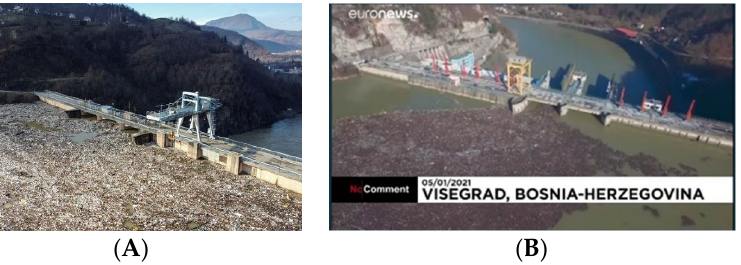
Figure 3. ( A ). Accumulation of litter debris, primarily plastic, near Potpecko Lake hydroelectric dam, Serbia, 5 January 2021. (Credits: REUTERS/Branko Filipovic). ( B ). Accumulation of litter debris, primarily plastic, near River Drina hydroelectric dam, 5 January 2021 (Credits: Euronews).